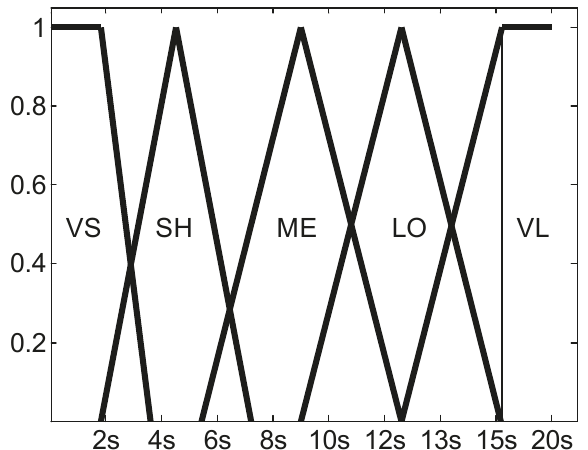
Figure 8. Membership functions of fuzzy sets in 𝜏 (cid:3038) (cid:3036) (expected sojourn time of the i -th model).